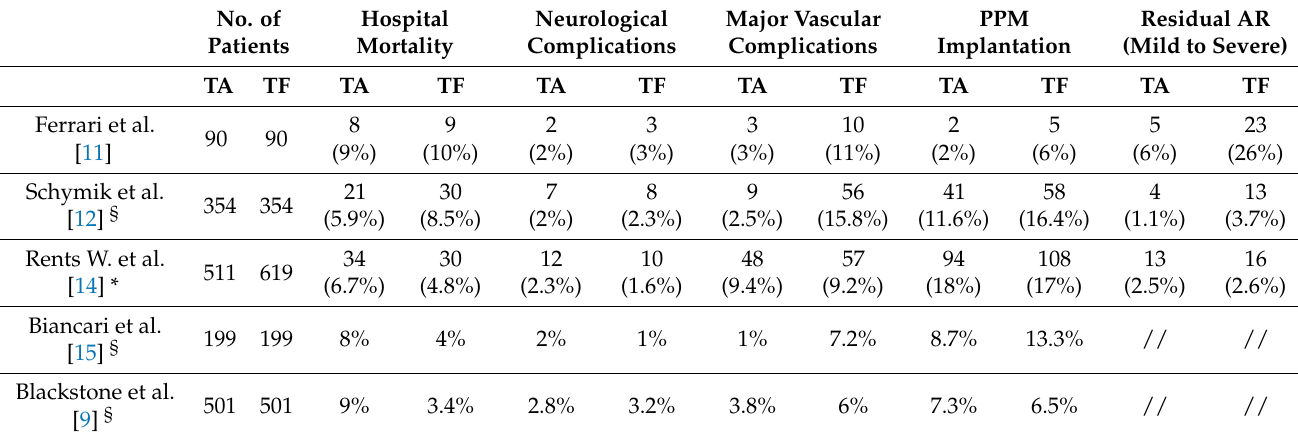
Table 1. Studies comparing results of TA vs. TF